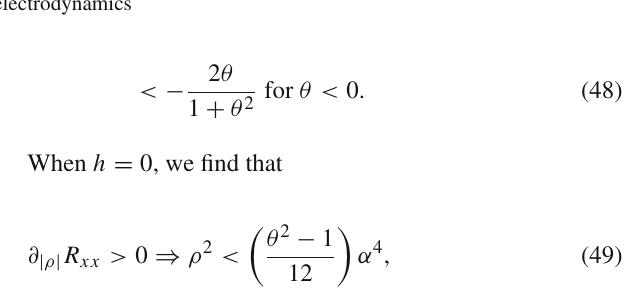
Fig. 4 Plots of R xx with θ = 3 at T = 0 for Maxwell–Chern–Simons